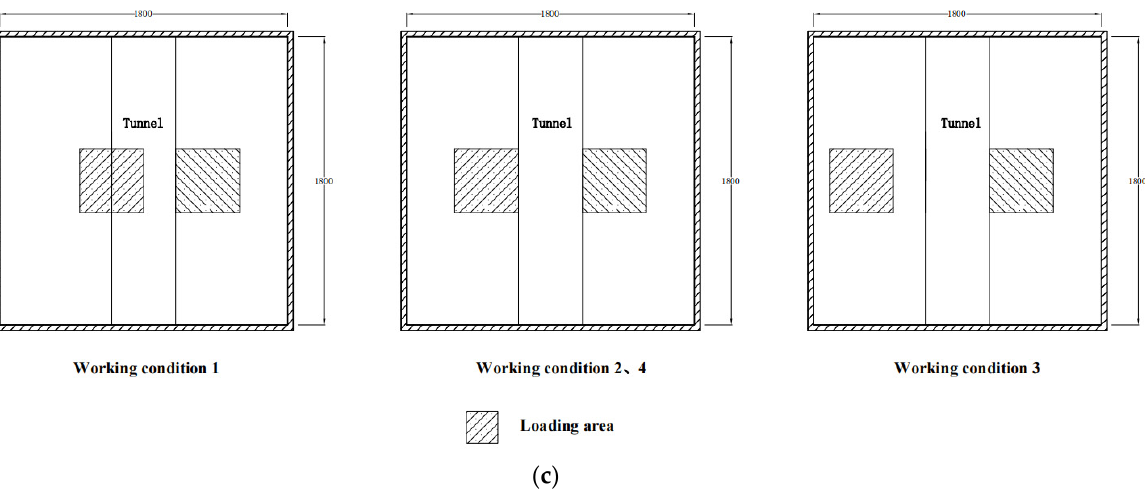
Figure 3. Schematic diagram of the test arrangement (unit: mm): ( a ) Plan view of measurement point arrangement. ( b ) Section view of measurement point arrangement. ( c ) Surcharge schematic diagram.